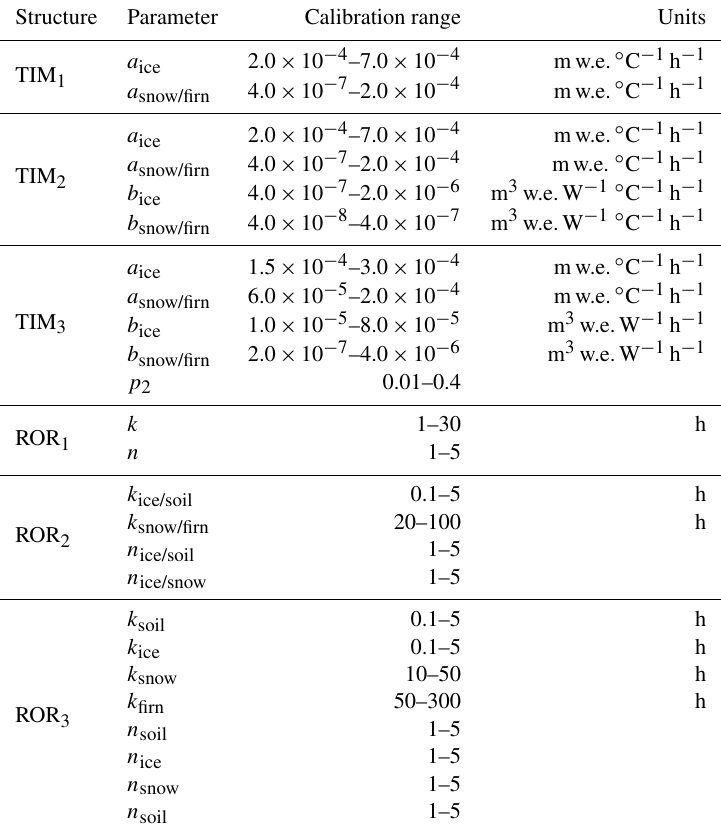
Table C1. Calibration parameters for the melt and run-off-routing model